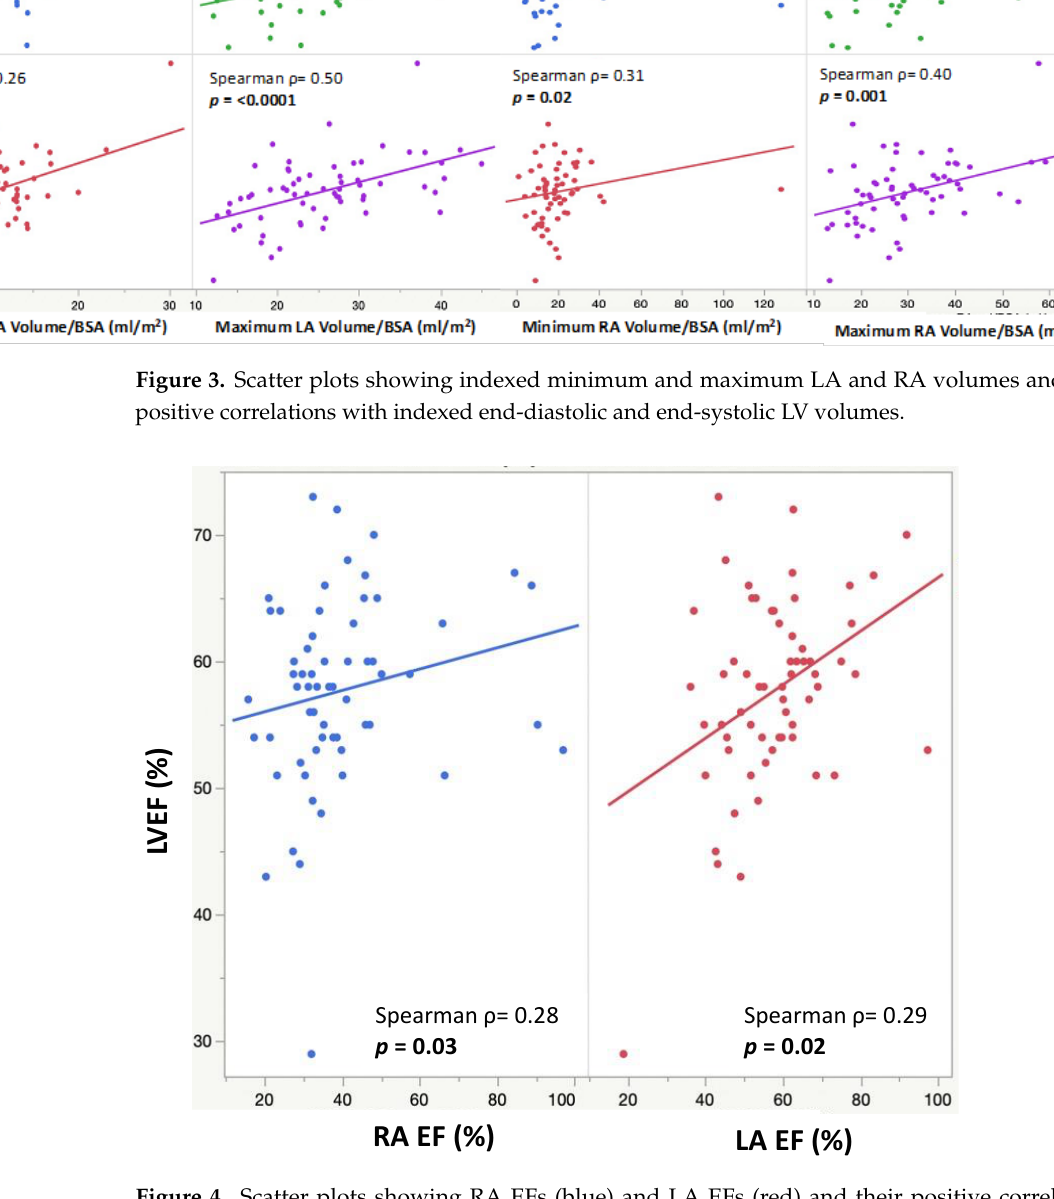
Figure 4. Scatter plots showing RA EFs (blue) and LA EFs (red) and their positive correlations with LVEFs.